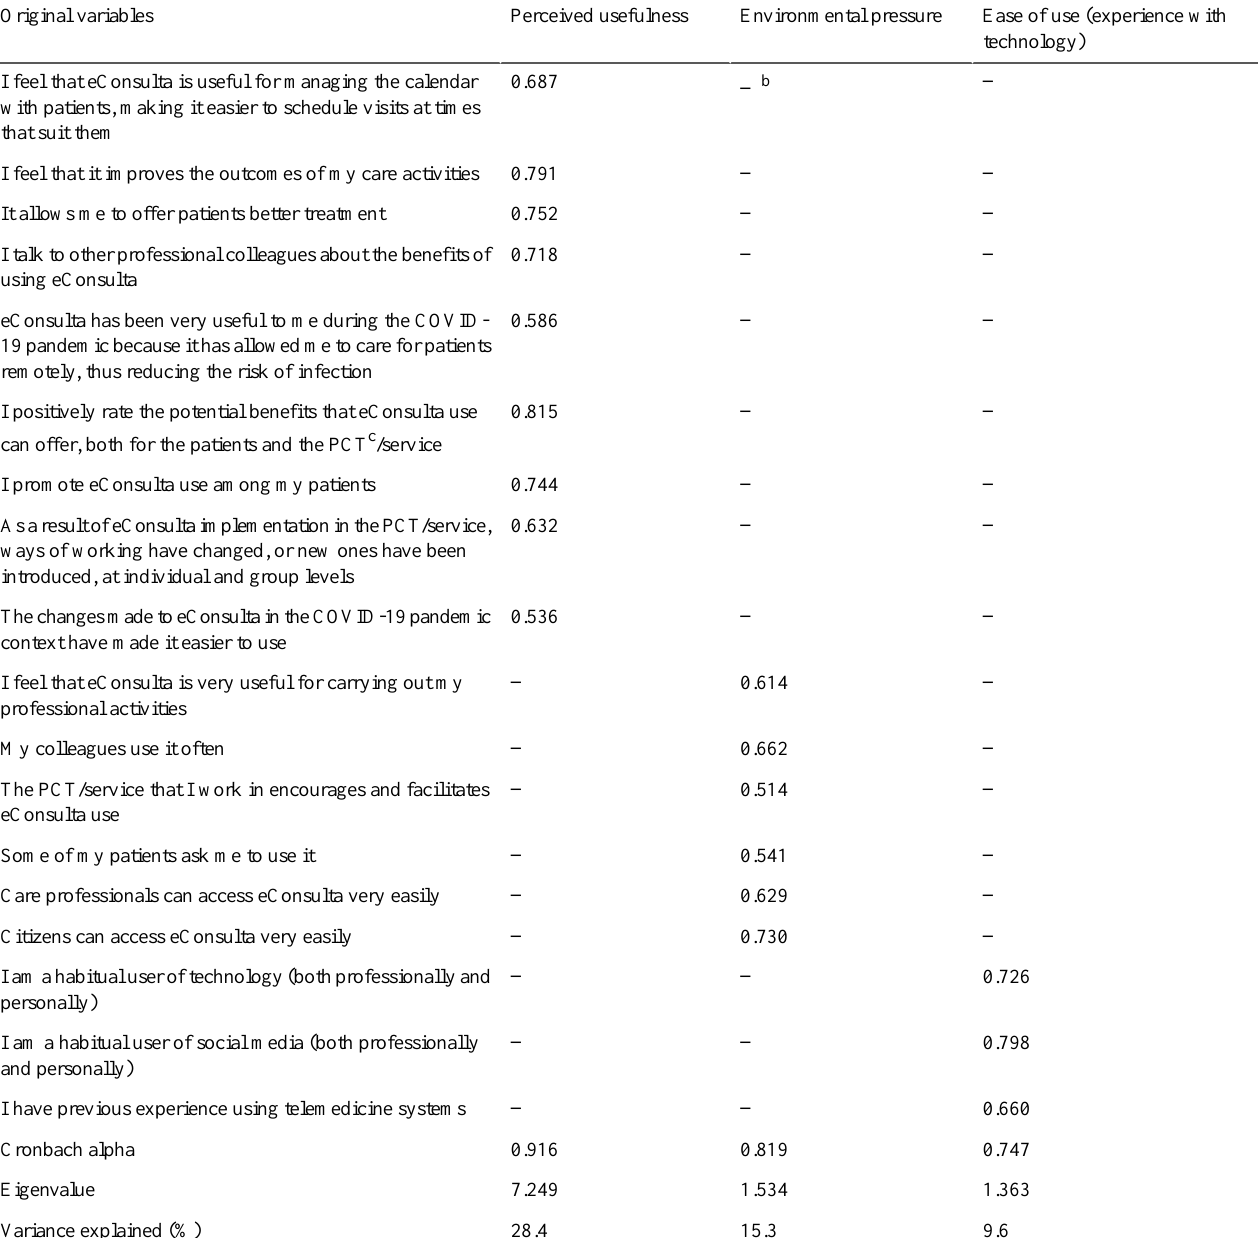
Table 2. Rotated component matrix. a